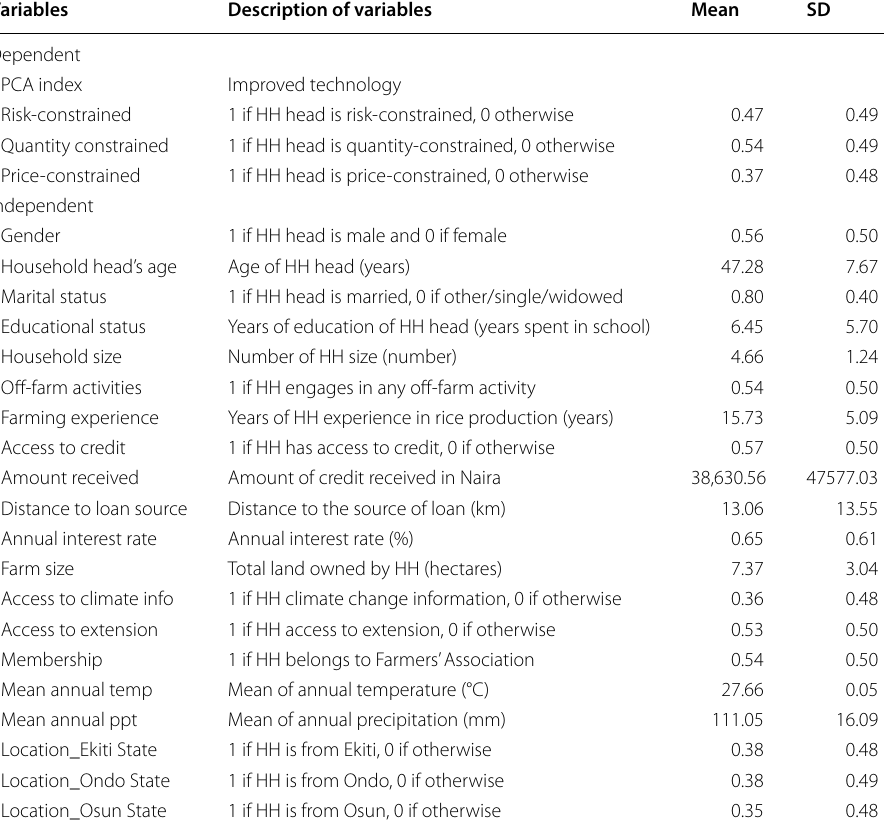
Table 2 Definitions and summary statistics of variables used in the model Variables Description of variables Mean